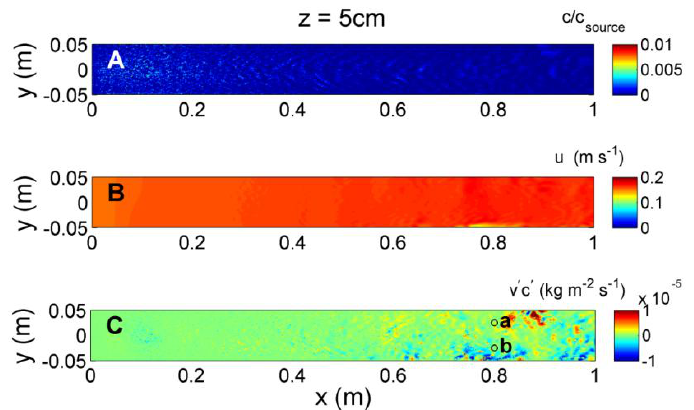
Figure 10. Instantaneous ( A ) odorant concentration, ( B ) horizontal velocity, and ( C ) transverse concentration flux ( v’c’ ) at z = 5 cm above the flume bed, obtained at t = 10 s after initial release of